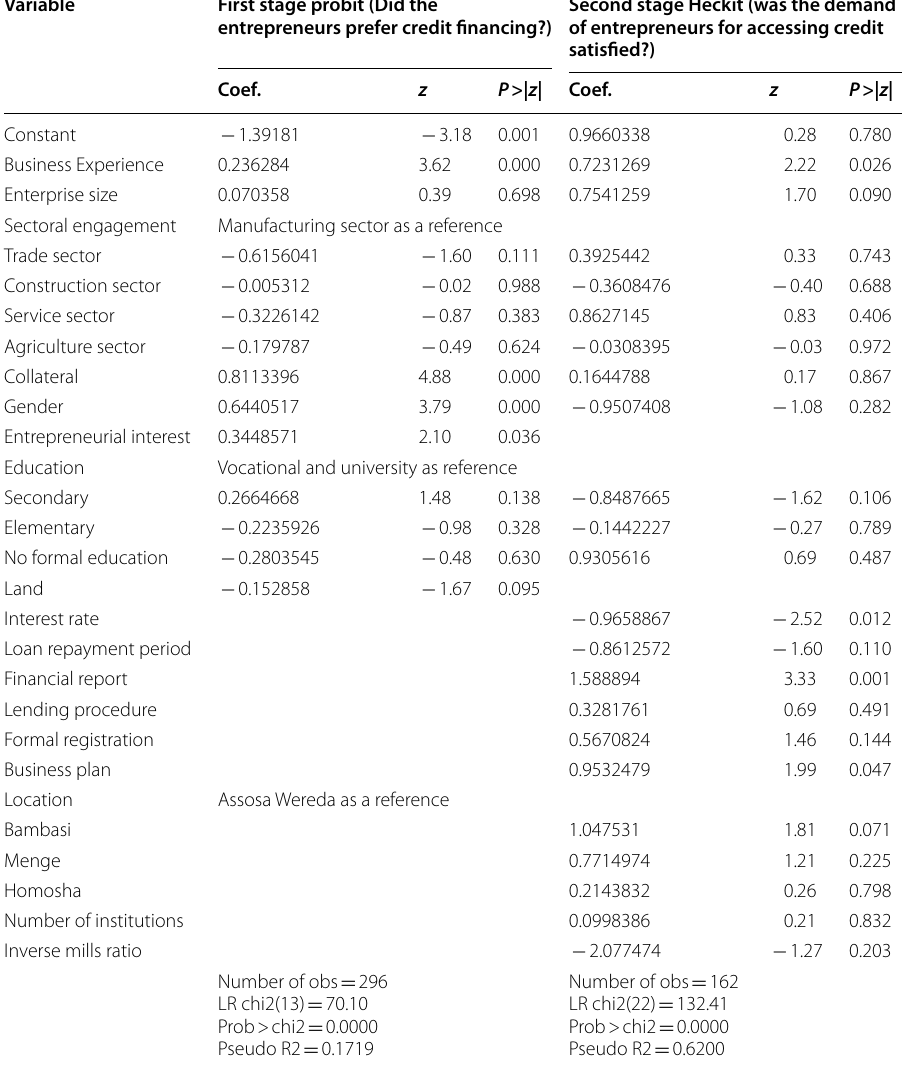
Table 13 Heckman two-step procedures: coefficient estimates from selection bias model